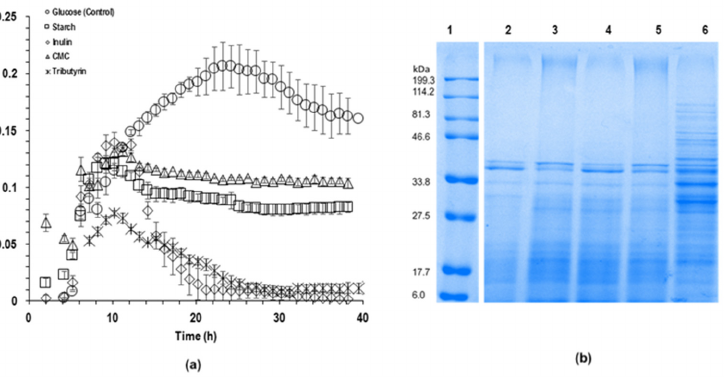
Figure 2. Influence of the carbon source on growth and protein expression. ( a ) Kinetic growth for B. pumilus UAMX under different carbon sources; ( b ) tris-glicine SDS-PAGE 12% for soluble cytosolic protein fraction of B. pumilus UAMX [line 1 (Broad Range MW standard, BioRad, Hercules, CA, USA), line 2 (glucose), line 3 (starch), line 4 (inuline), line 5 (CMC), and line 6 (tributyrin)].